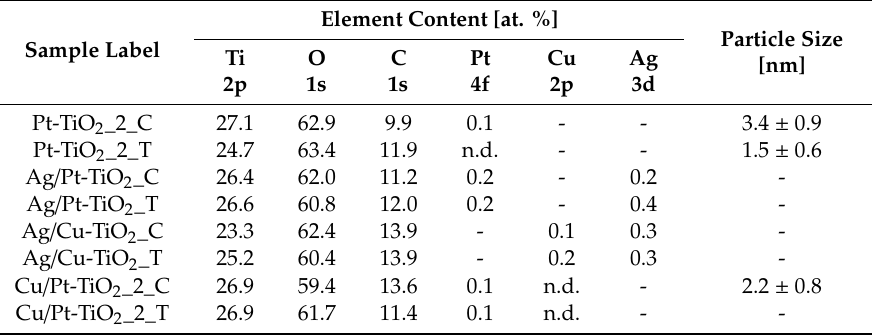
Table 2. X-ray photoelectron spectroscopy (XPS) analysis of Ti, O, C, Pt, Cu and Ag.